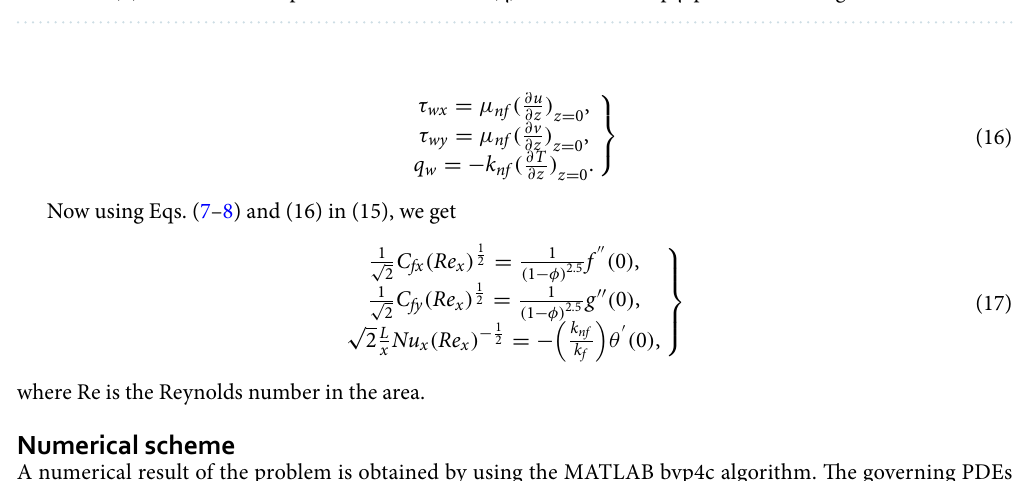
Figure 7. ( a ) Influence of temperature distribution θ(η) over thermal slip β parameter for CuO-water nanofluid. ( b ) Influence of temperature distribution θ(η) over thermal slip β parameter for Ag-water